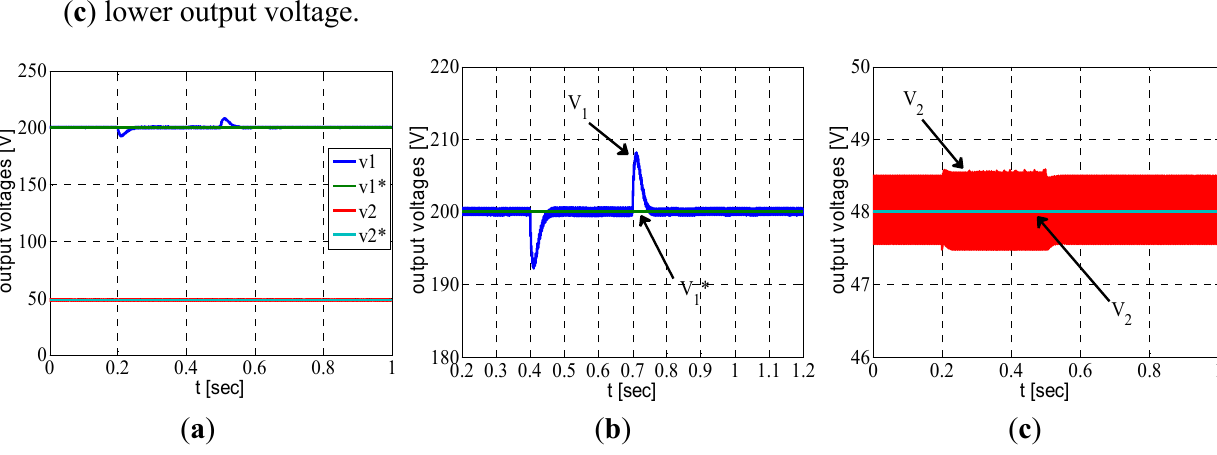
Figure 15. Double load step variation results: ( a ) output currents; ( b ) higher level output current.